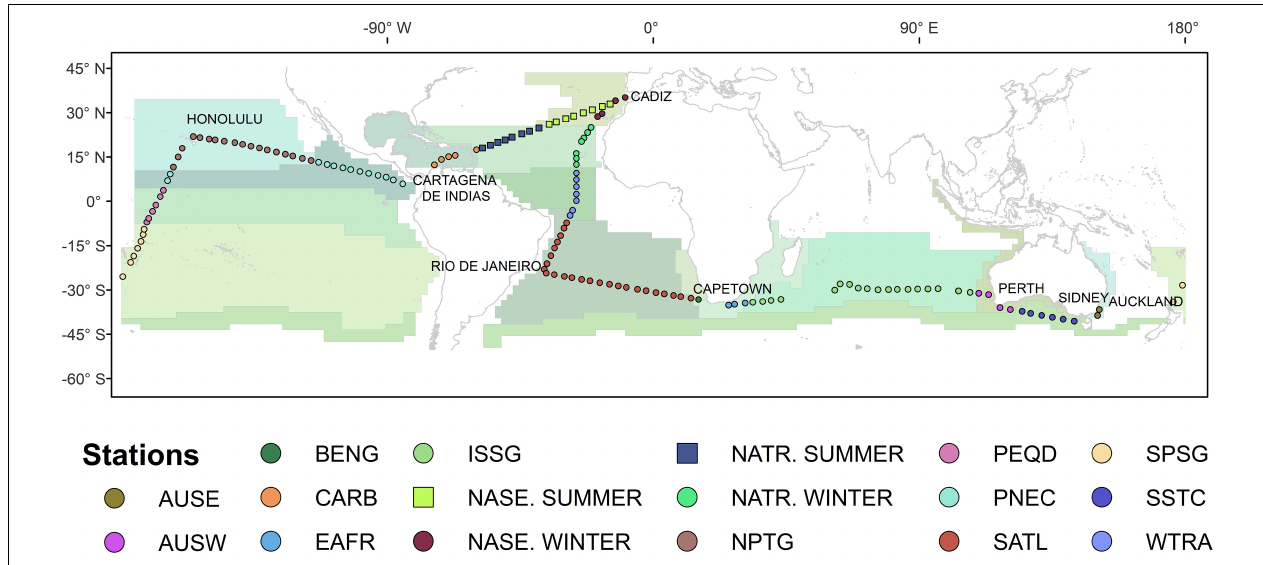
FIGURE 1 | Map of the biogeographic provinces with the 147 stations crossed during Malaspina 2010 expedition. The positions of the stations sampled between 35 ◦ N and 40 ◦ S are marked with circles. Different colors of the circles indicate the different 15 biogeographic provinces, parceled by Longhurst’s classification (1995, 1998, 2007). AUSE, East Australian Coastal Province; AUSW, Australia-Indonesia Coastal Province; BENG, Benguela Current Coastal Province; CARB, Caribbean Province; EAFR, E. Africa Coastal Province; ISSG, Indian S. Subtropical Gyre Province; NASE, N. Atlantic Subtropical Gyral Province; NATR, N. Atlantic Tropical Gyral Province, NPTG, N. Pacific Gyre Province; PEQD, Pacific Equatorial Divergence Province; PNEC, N. Pacific Equatorial Countercurrent Province; SATL, South Atlantic Gyral Province; SPSG, S. Pacific Subtropical Gyre Province; SSTC, S. Subtropical Convergence Province; WTRA, Western Tropical Atlantic Province. Note the different colors for the same province NASE and NATR, crossed both in winter and in summer. (For more details see Catalá et al., 2016 and Supplementary Table S1